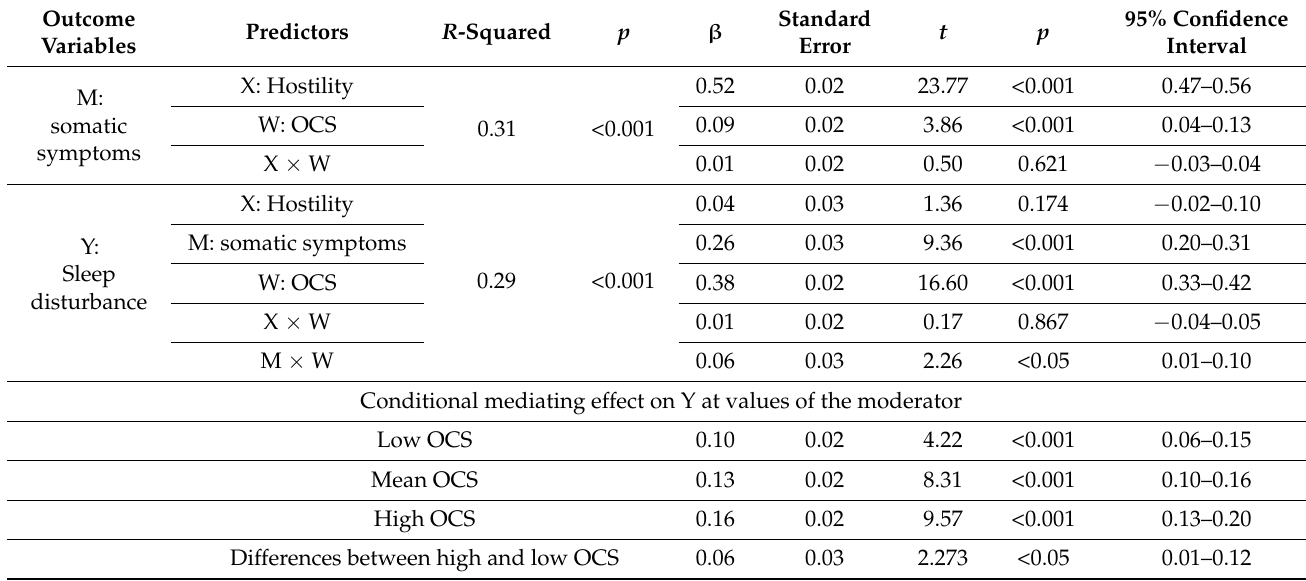
Table 6. The moderating effect test of OCS on the mediator effect.